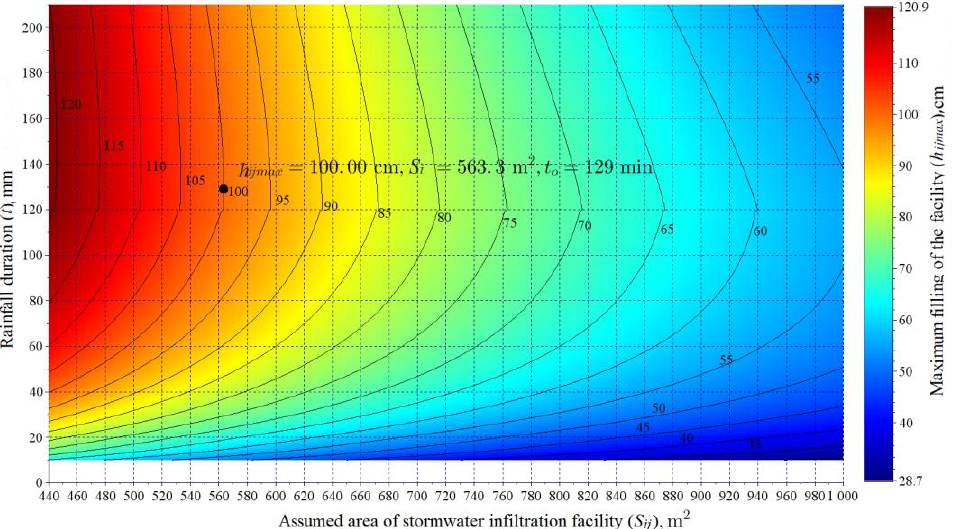
Figure 4. The maximum level of fill in an infiltration tank ( h ijmax ) as a function of the duration of rainfall ( t ) and the bottom area of the facility ( S ij ), determined for a randomly selected catchment ( h ijmax —maximum level of fill in the tank at a given area of its bottom; S i —required area of the tank; t o —critical rainfall